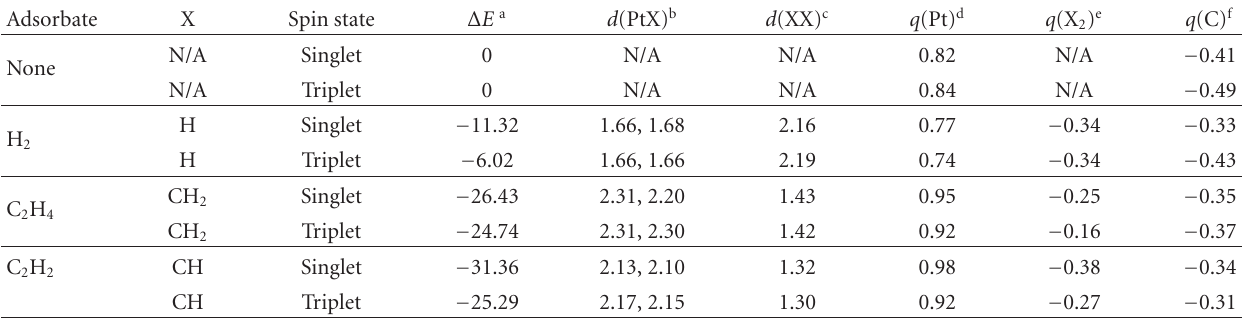
Table 5: Binding energy and geometrical data for nanotube-adsorbate complexes C 69 H 20 Pt(X 2 ) with side-on binding motif [113,